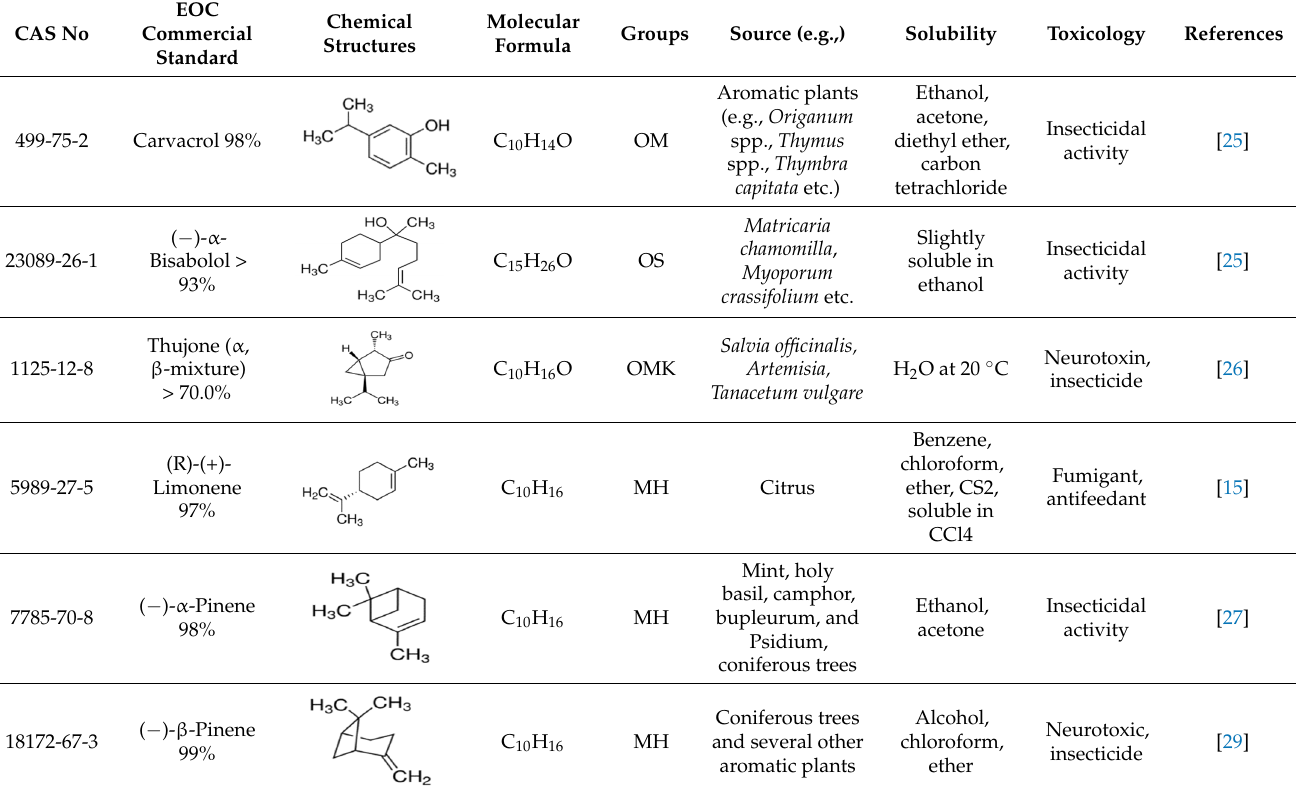
Table 1. List of EOCs used in the current study along with chemical structure and their sources.